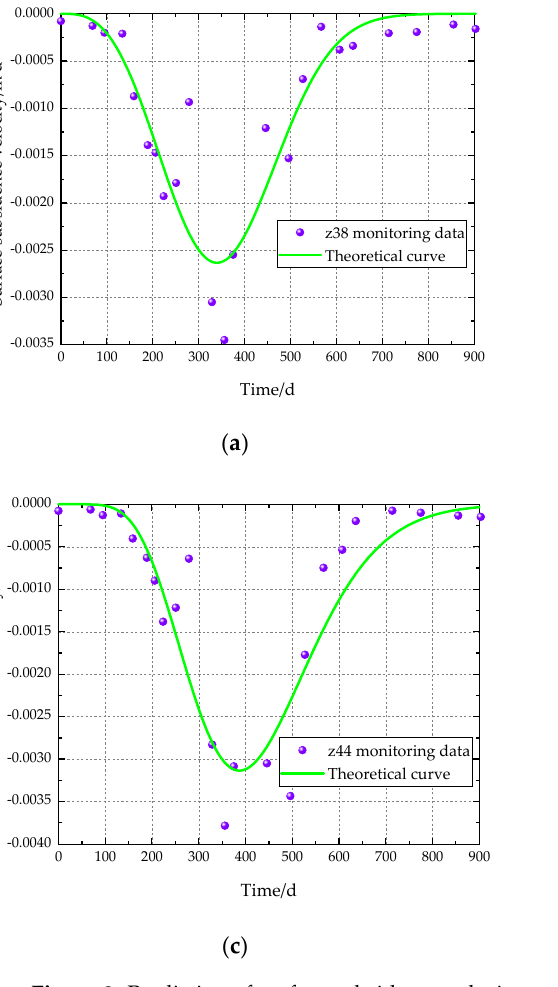
Figure 9. Prediction of surface subsidence velocity curve by the improved Knothe time function model: ( a ) z38; ( b ) z41; ( c ) z44; ( d ) z47. Table 2. Time influence parameters of di ff erent main strike profile monitoring points. Monitoring Points Model Parameter